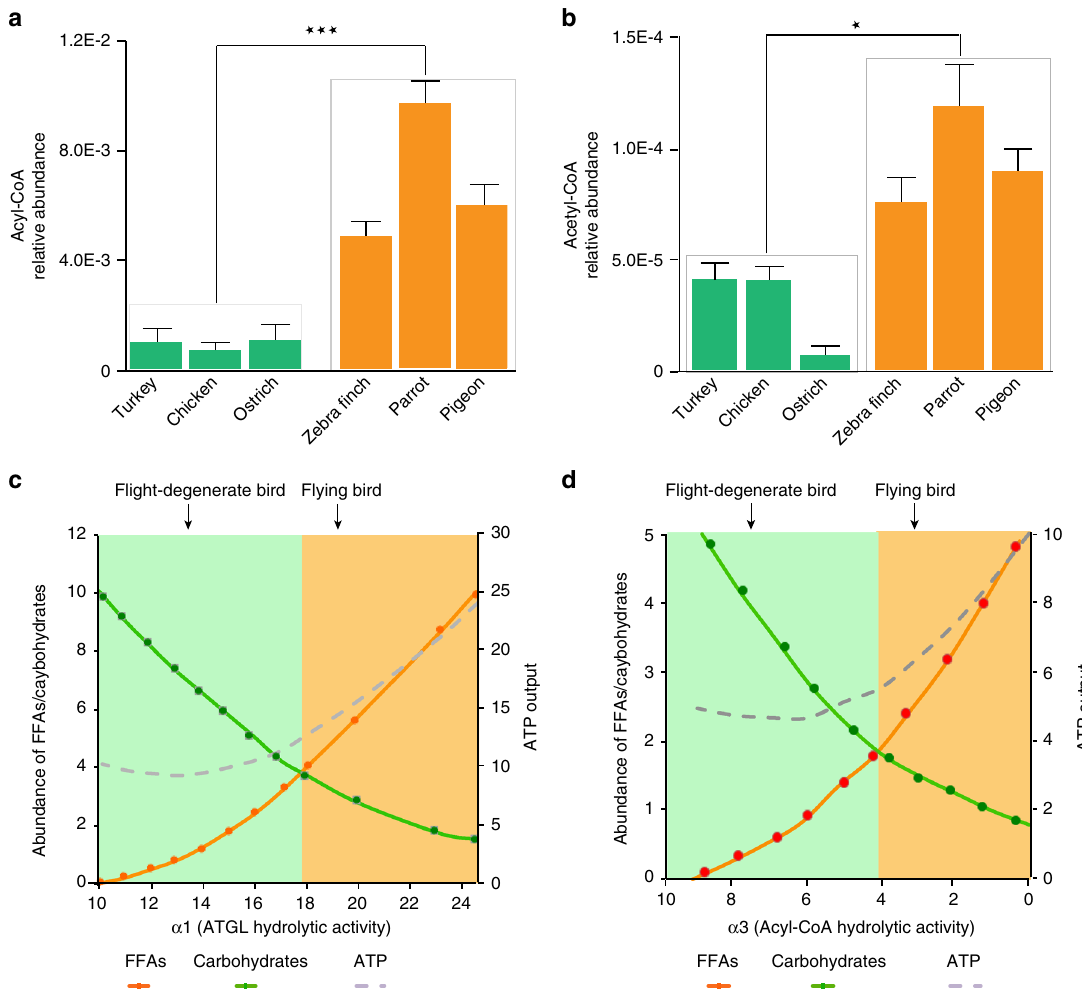
Fig. 4 Modeling simulations of effects of functional changes on the energy landscape. The actual abundance of acyl-CoA a and acetyl-CoA b was measured in three fl ight-degenerate (turkey, chicken and ostrich) and three fl ying species (zebra fi nch, parrot and pigeon) using LC – MS. The simulated results for ATGL and ACOT7 are shown in c and d respectively. * P < 0.05, *** P < 0.001 by Wilcoxon rank sum test. Error bars indicate s.e.m. Source data are